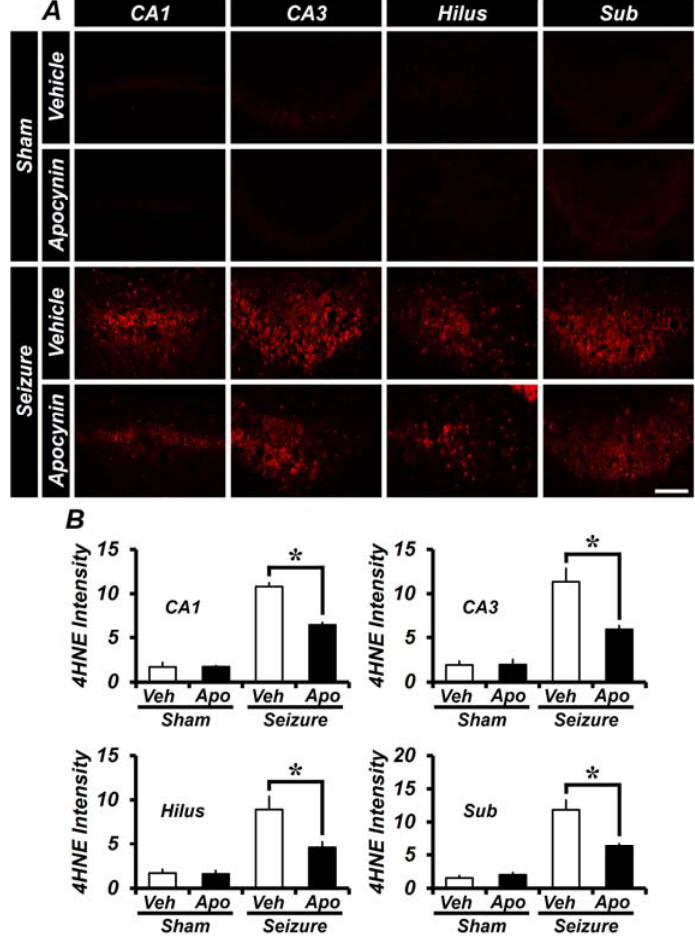
Figure 2. Apocynin administration reduces oxidative injury after seizure. Oxidative stress was observed by anti-4-hydroxynonenal (4HNE) immunostaining after one week of seizure. ( A ) The intensity of 4HNE was increased in the seizure-vehicle group when compared to the sham group. In the seizure-apocynin treated group, the 4HNE intensity was lower than the vehicle treated group. Scale bar = 100 μ m. ( B ) The bar graph shows the 4HNE fluorescence intensity of the hippocampus shown in ( A ). Data: Mean ± S.E.M., n = 5–6 from each group, * p < 0.05.